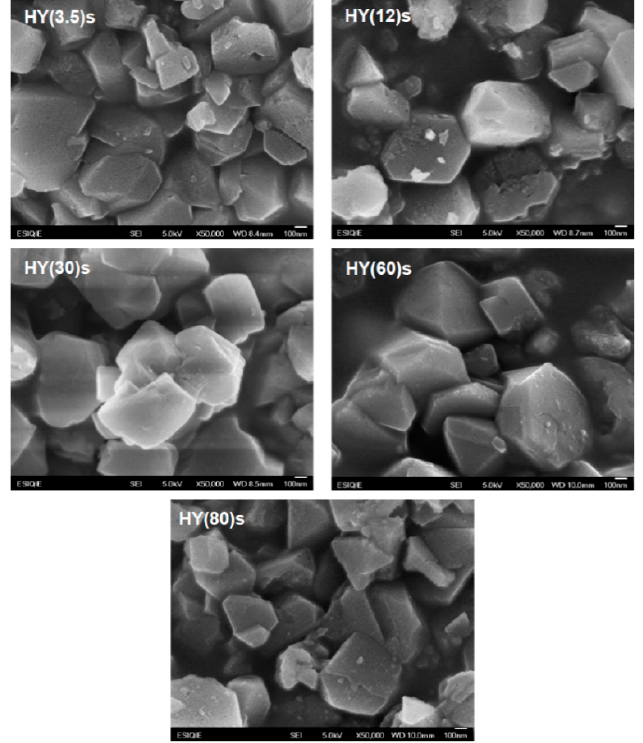
Figure A2. SEM micrographs of the spent HY zeolites. Table A1. Elemental composition of the HY zeolites determined by EDXS.